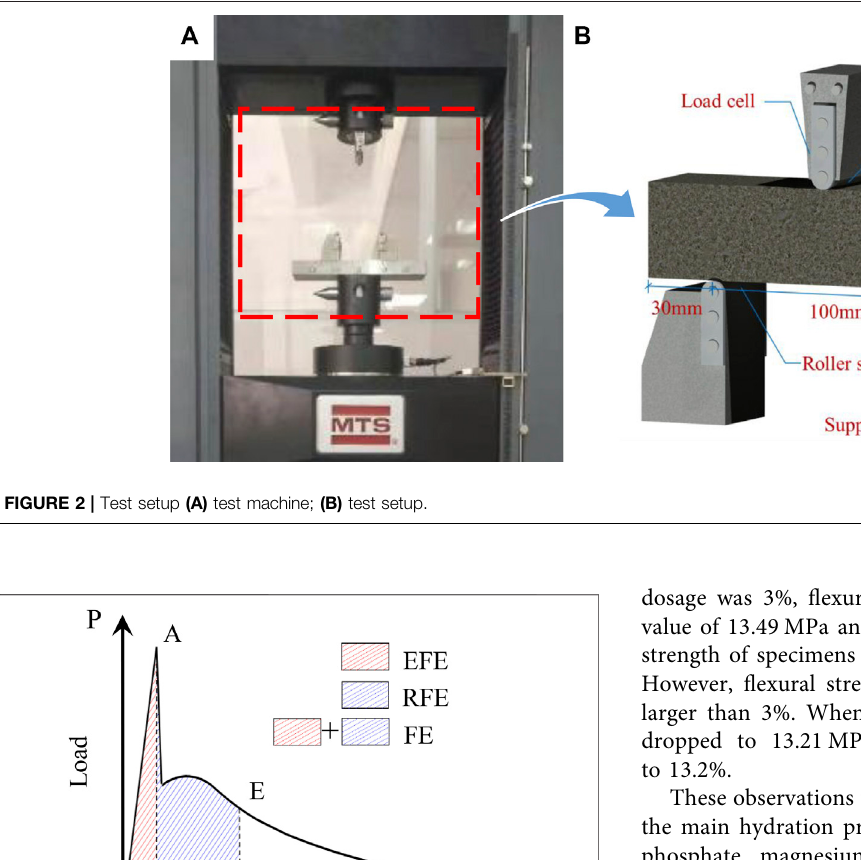
uneven than the fracture surfaces of F1 and F2, as presented in Figure 5C . Group F4 and group F5 showed a similar failure mode to group F3, which is illustrated in Figures 4D,E , respectively.